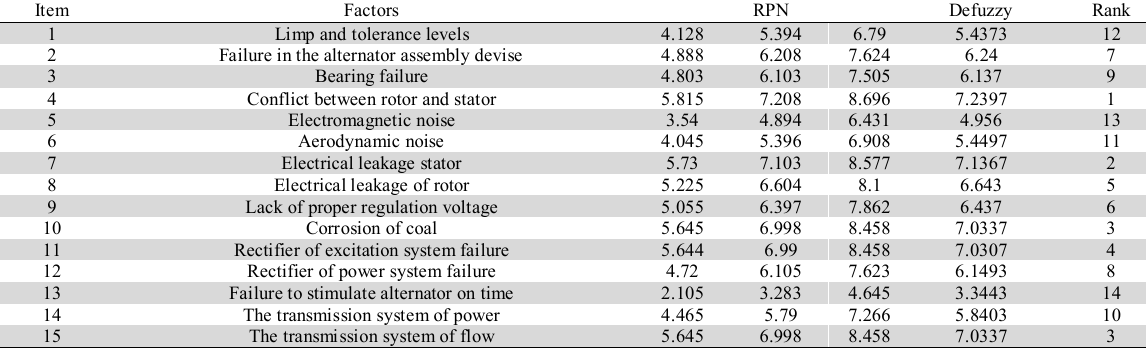
The results of final